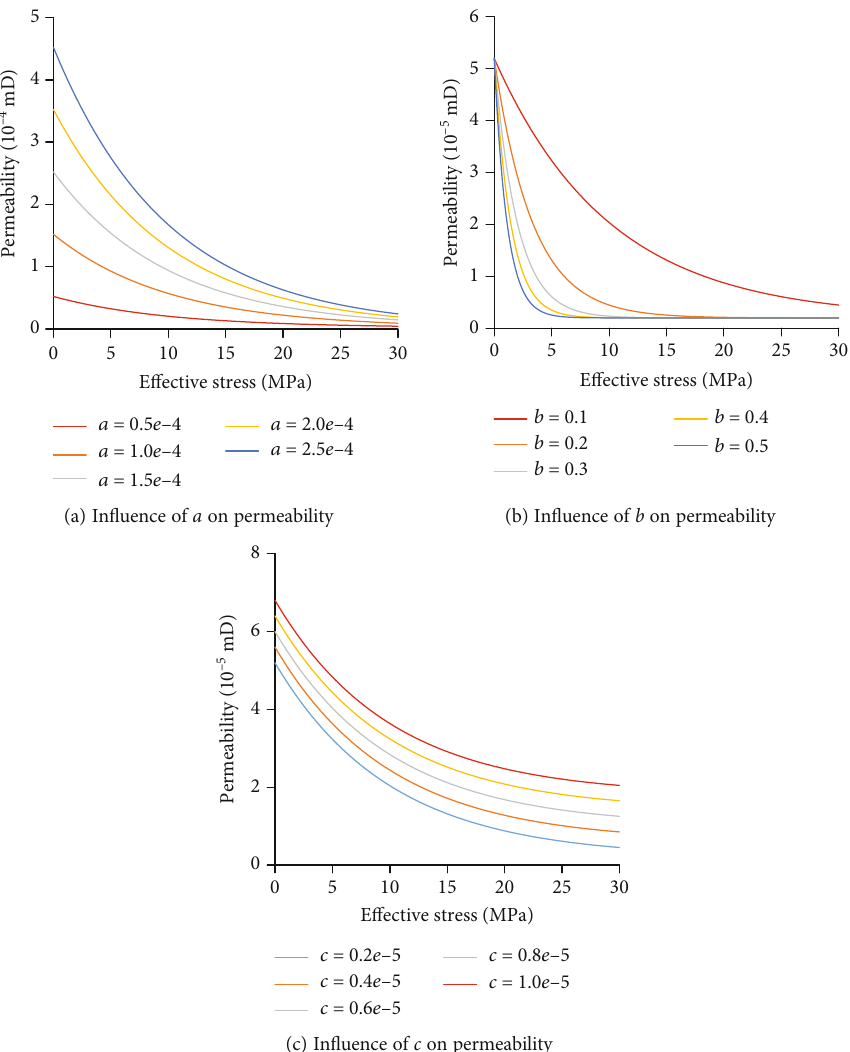
Figure 10: The parameter analysis for the improved exponential model.